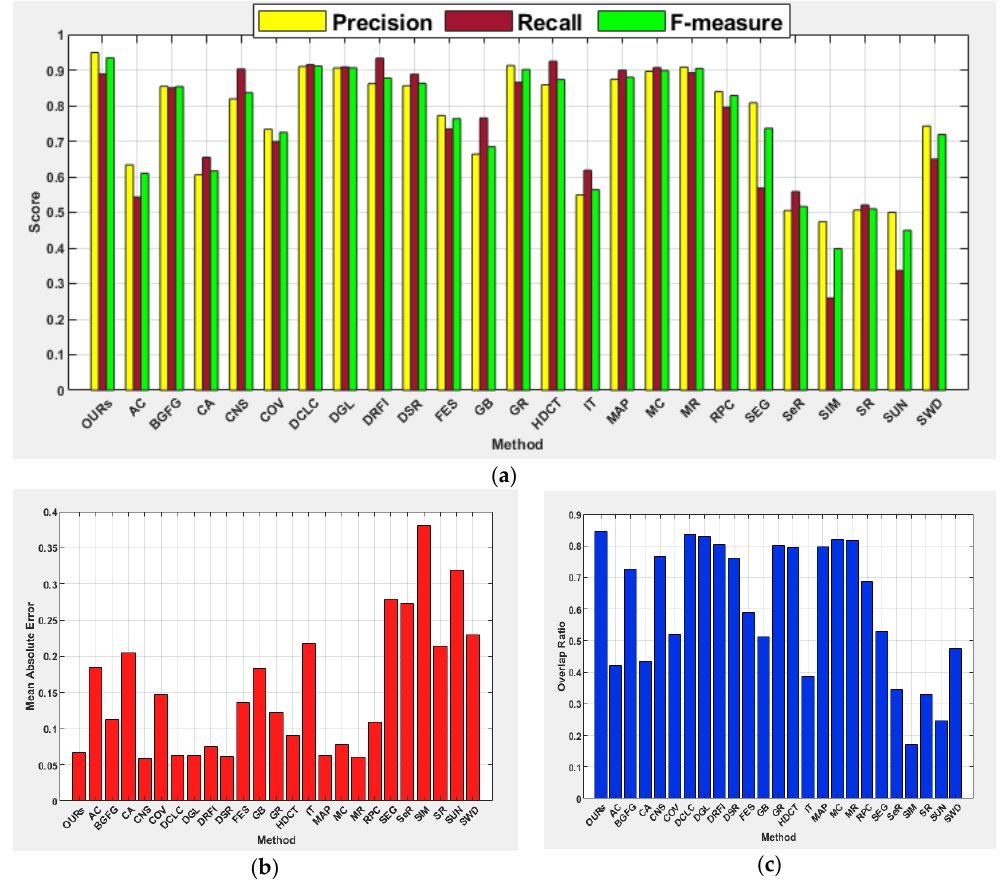
Figure 6. ( a ) F-measure; ( b ) MAR and ( c ) OR on image category: